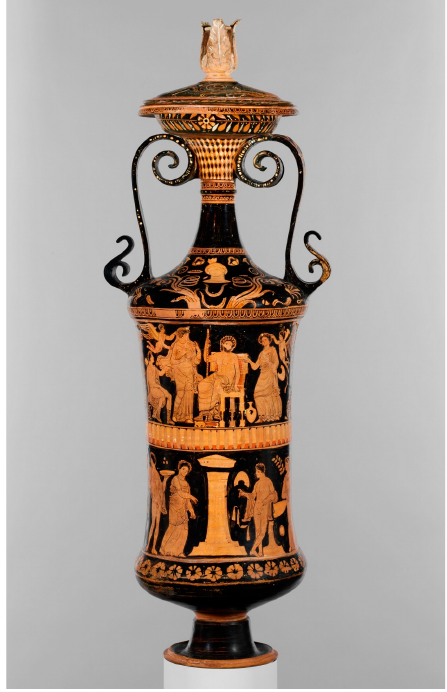
Figure 15. New York, Metropolitan Museum of Art 11.120.3a,b Apulian loutrophoros, Darius Painter, ca. 340–330 B.C. Female head in floral surround emerging from acanthus (lid), female head rising from flower and flanked by floral tendrils (shoulder), male deity (Hades? Zeus?) adjudicating between Persephone and Aphrodite regarding Adonis’ immortality (upper register on body), grave stele between youths and women (lower register on body). Image © The Metropolitan Museum of Art.